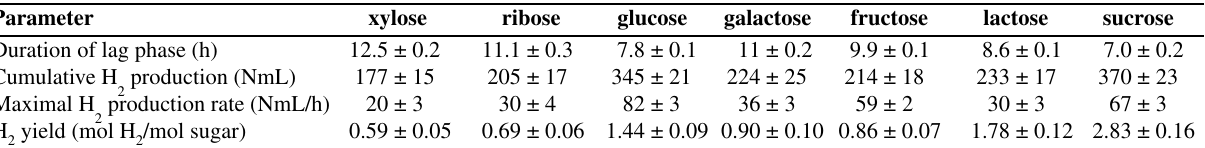
Table 3. Hydrogen production by anaerobic sludge from mono- and disaccharides. Parameter xylose ribose